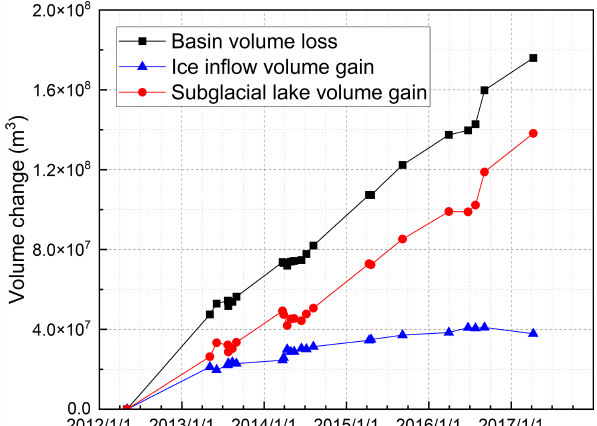
Figure 4. Volume change of the collapse basin, ice inflow and the subglacial lake relative to 3 May 2012. Volume gain of the sub- glacial lake, which is caused by influx of surface meltwater, is de- rived by differencing the basin volume loss and ice inflow volume gain. DEMs with large voids in the buffer area were discarded to avoid potential biases. Dates are in the format